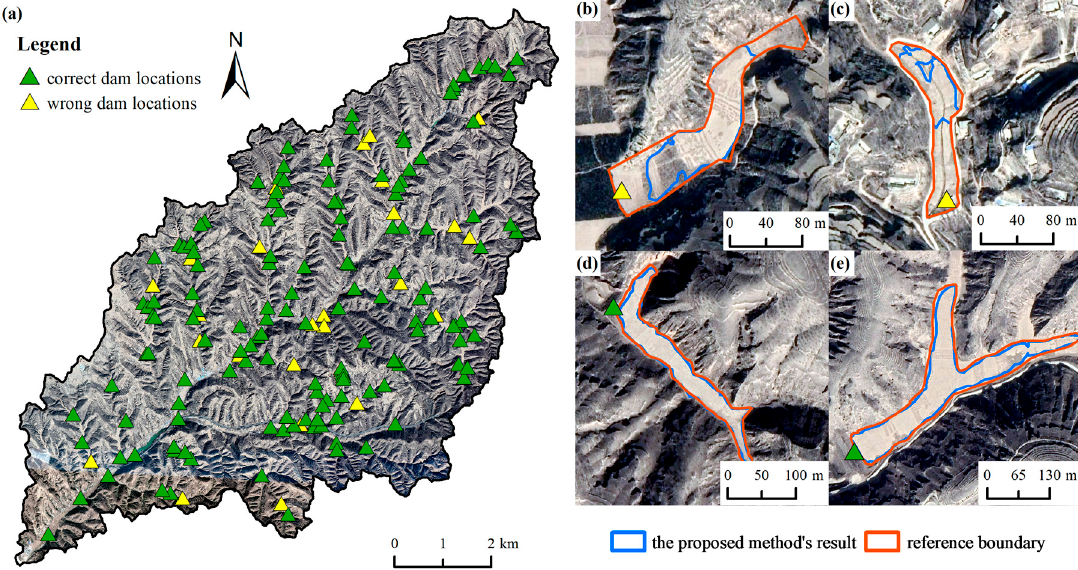
Figure 9. ( a ) The distribution of extracted dam locations; ( b , c ) enlarged images of small check dam systems; ( d , e ) enlarged images of medium and large check dam systems.